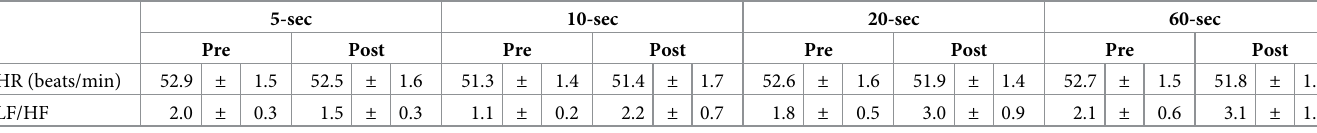
Table 2. HR and LF/HF before (Pre) and after (Post) passive one-legged calf stretching.